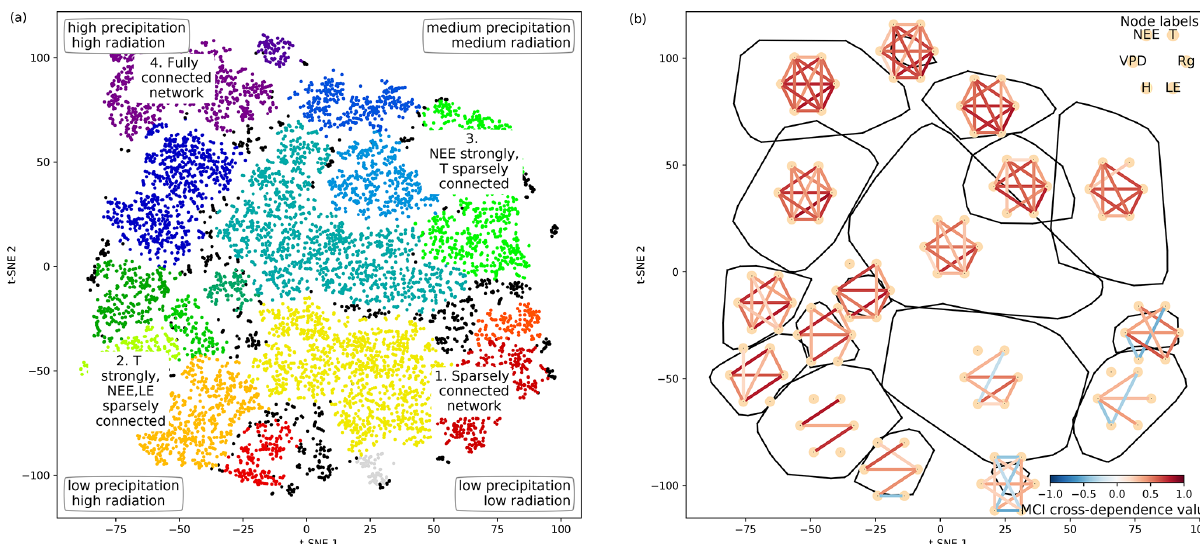
Figure 4. Structure of the two-dimensional embedding. (a) t -SNE space clustered by the OPTICS approach (Ankerst et al., 1999). Colours represent different clusters; black dots are not attributed to a cluster. Indicated are the four archetypes of network connectivity and the networks’ underlying meteorological conditions. (b) Convex hulls of clusters and their average network, i.e. average over all networks belonging to one cluster. Average networks are thresholded at a minimum link strength of 0.2. A finer clustering can be found in Fig. B5 in the